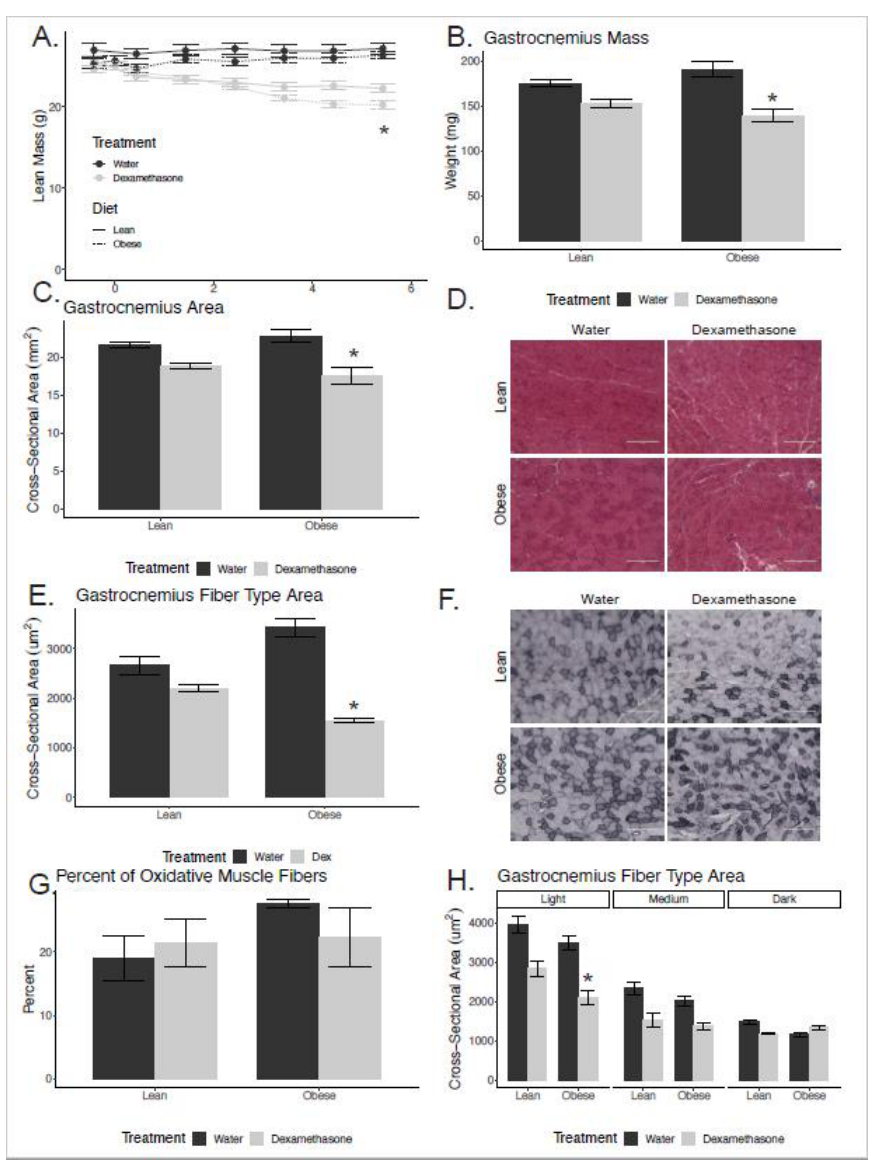
Figure 2. Obese dexamethasone-treated mice have reduced muscle size. ( A ) Lean mass determined via EchoMRI. Gastrocnemius muscle mass ( B ) and cross-sectional area (( C ) from lean and obese mice treated with vehicle (water) or dexamethasone (n = 5–8 per group). H&E-stained section of muscles (quadriceps; ( D )). Average fiber cross-sectional area ( E ) averaged from 200 fibers per section (quadriceps; n = four mice per group). NADH/NBT-stained section of muscles (quadriceps; ( F )) from mice treated with water or dexamethasone for six weeks. Percent of slow-oxidative or Type I fibers to total fibers (( G ); n = four sections per group). Average fiber cross-sectional area separated by NADH/NBT staining density with dark fibers indicating slow-oxidative or Type I muscle fibers